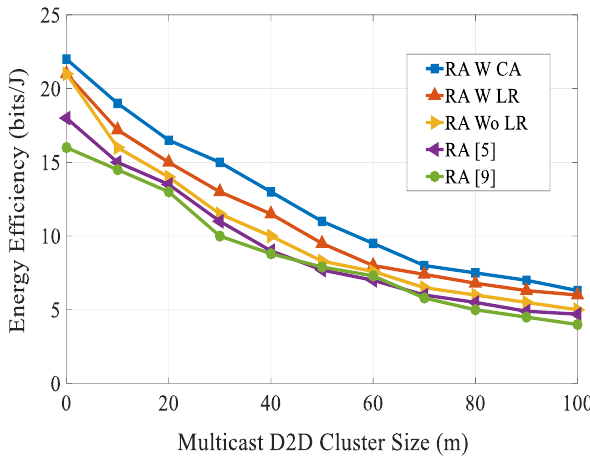
ffi ciency vs. multicast D2D group Figure 11. Energy efficiency vs. multicast D2D group size. Figure 11. Energy e Figure 11. Energy efficiency vs. multicast D2D group size.